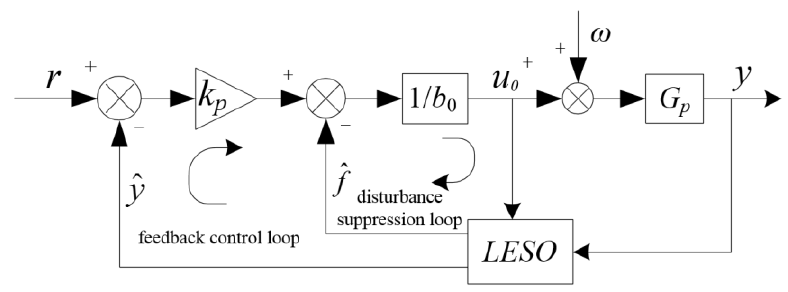
Figure 3. Structure of first-order LADRC.